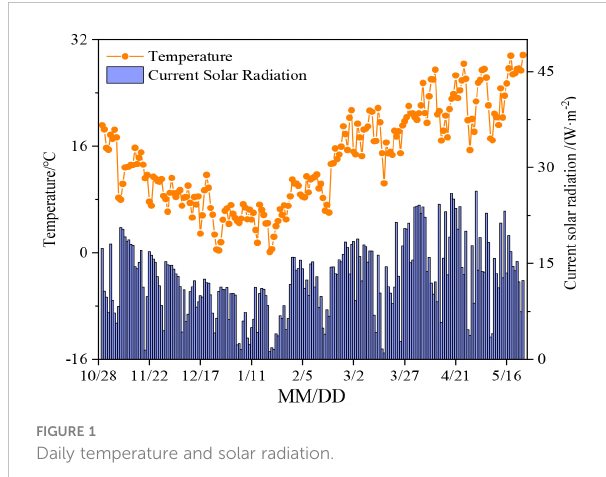
FIGURE 1 Daily temperature and solar